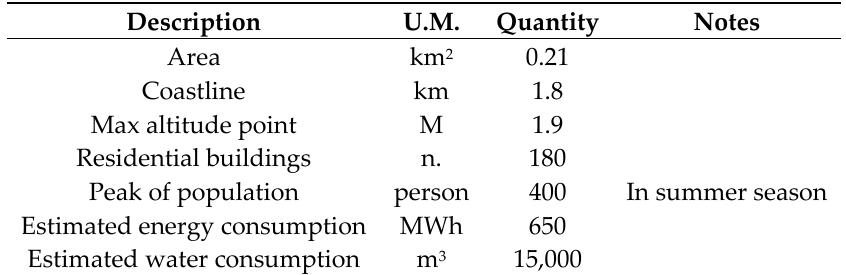
Table 1. Dimensional data input.